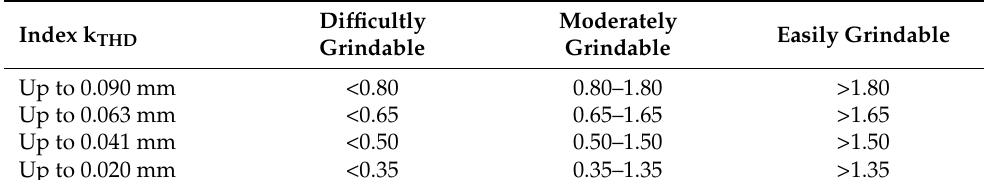
Table 16. New classification of material based on grindability index according to the new THD method.